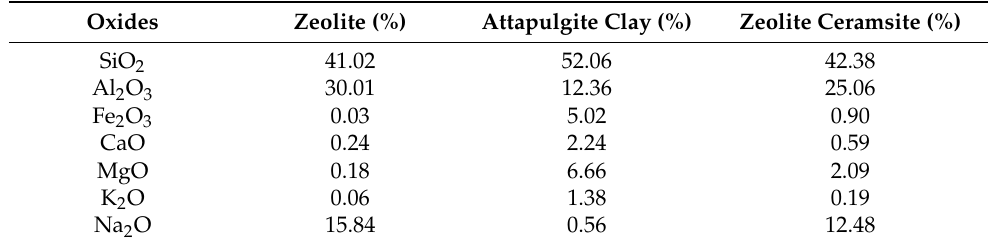
Table 2. Main chemical composition of samples.